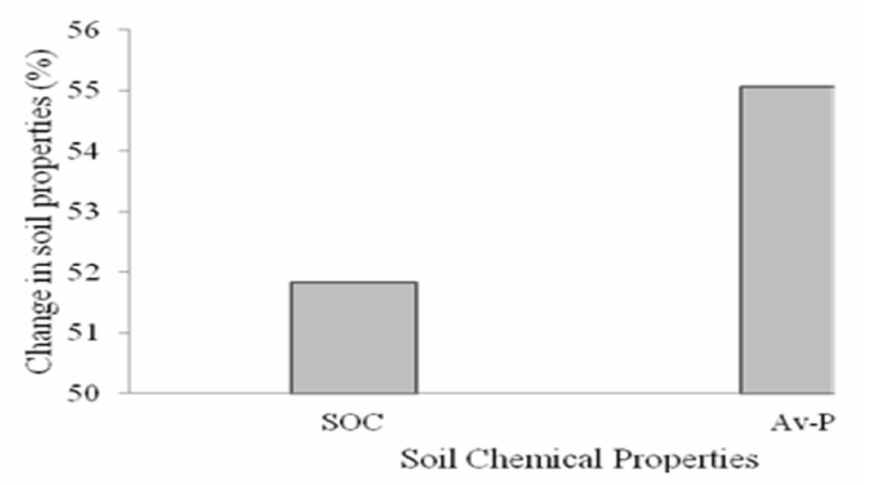
Figure 3. The increase in soil chemical properties due to natural rehabilitation of degraded land by exclosure within overall depth (0–40 cm). SOC refers to soil organic carbon; Av.P refers to available